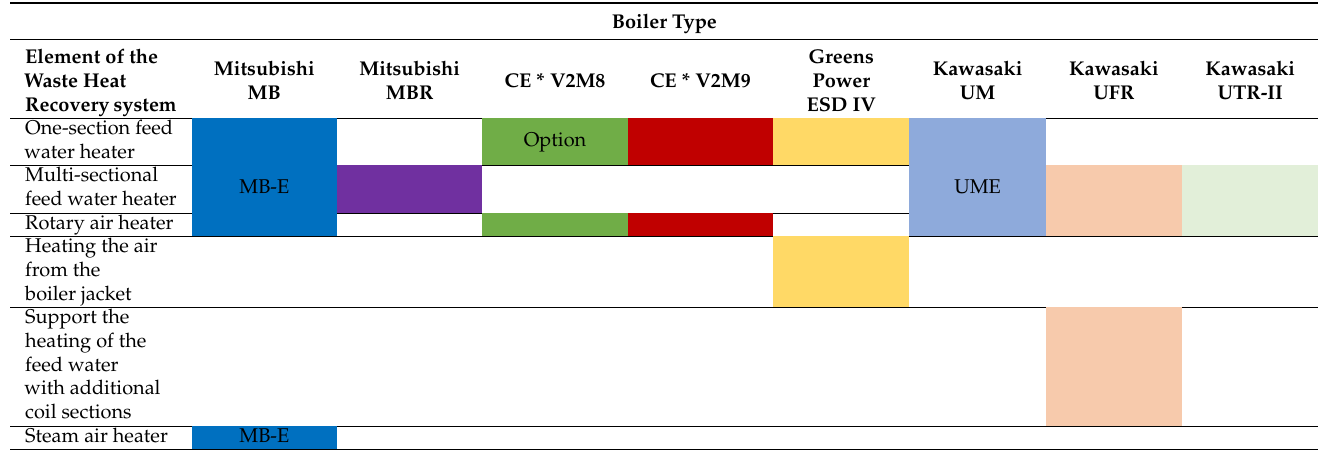
Table 2. Methods and heat exchangers for the utilization of waste heat from the main boilers [3–5,7,8,10,14–19]. Boiler